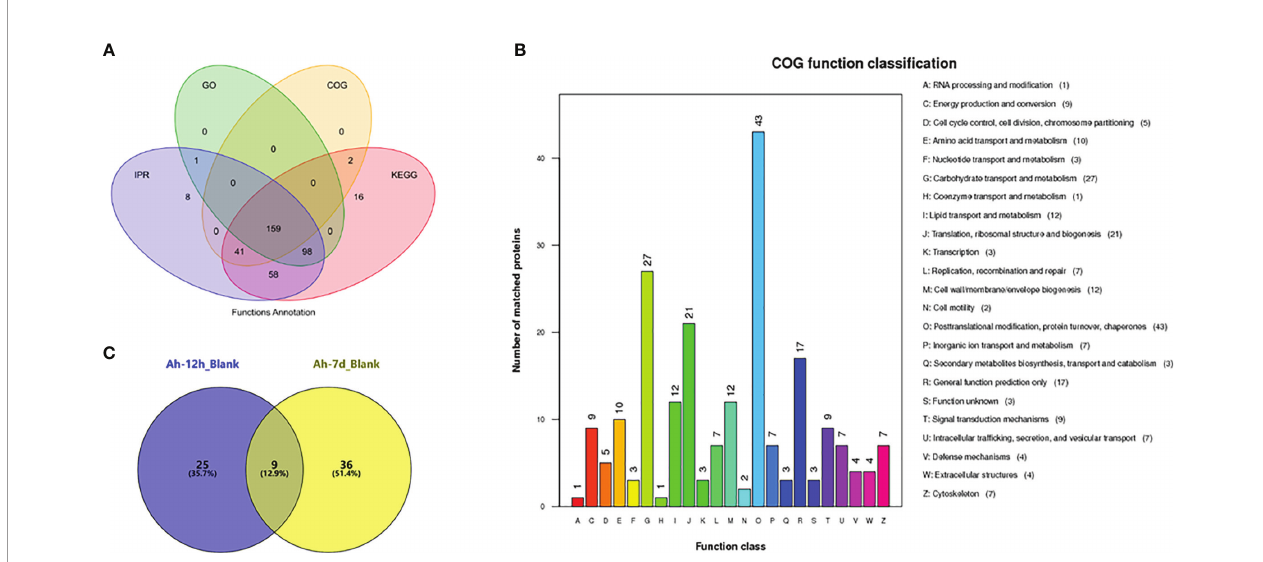
FIGURE 3 | Haemolymph proteins identi fi cation by iTRAQ proteomic analysis. (A) Functional annotation of identi fi ed haemolymph proteins based on the four databases, in which 383 proteins were functionally annotated. (B) The haemolymph proteins could be functionally classi fi ed into 23 classes based on COG annotation. (C) Quantitative expression analysis of haemolymph proteins, and there were 34 and 45 differentially expressed proteins in haemolymph of crabs at 12 hours (Ah-12h) and 7 days (Ah-7d) post priming stimulation, compared with that in blank crabs, respectively.